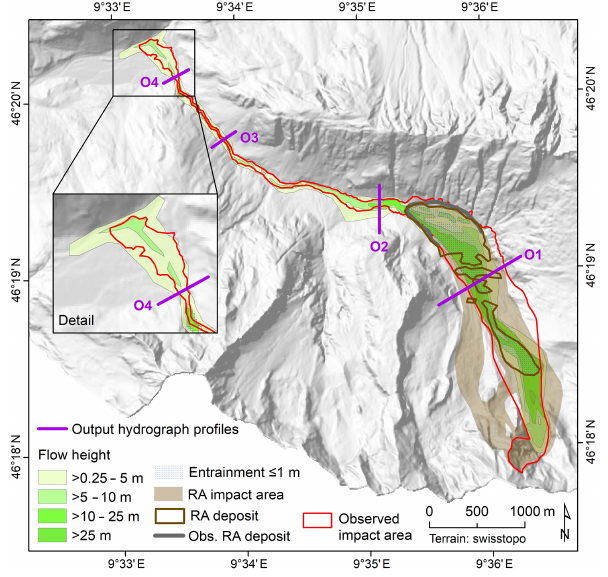
Figure 11. Maximum flow height and entrainment derived for Sce- nario S2. RA is rock avalanche; the observed RA terminus was de- rived from WSL (2017).